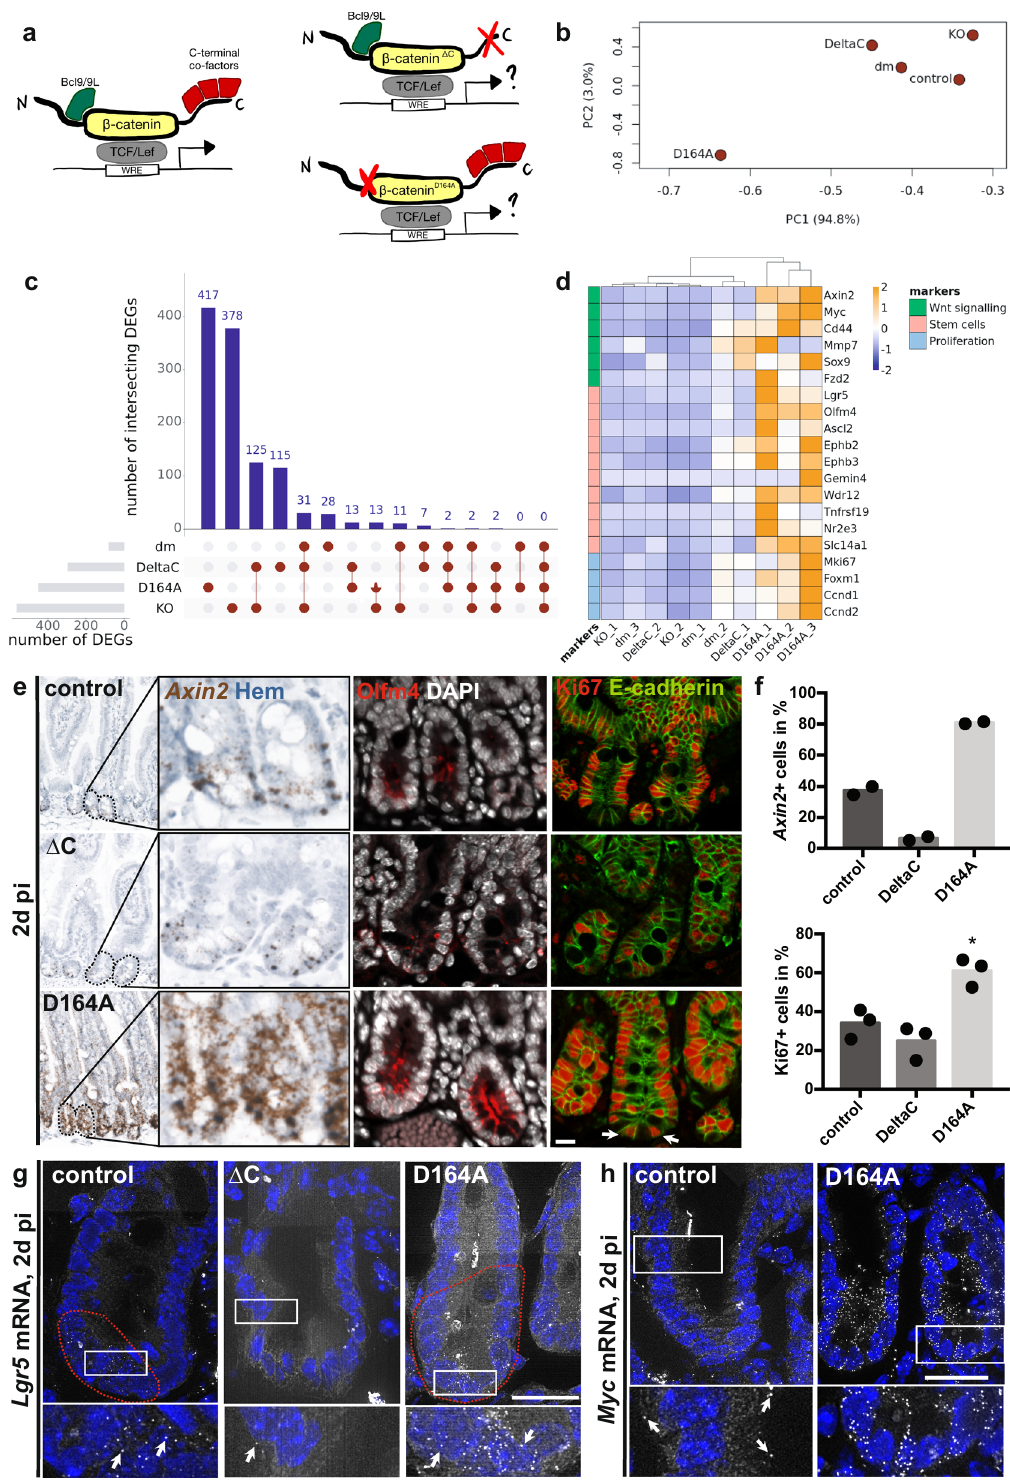
(Fig. 1g and Supplementary Fig. 2e). Furthermore, both the presence of Ki67 + cells at the bottom of D164A crypts (white arrows in Fig. 1e, and evidenced in Supplementary Fig. 2f) and upregulated Myc expression at crypt base (Fig. 1h) indicate increased IESC proliferation. These results indicate that prevent- ing β -catenin ’ s interactions to CTFs completely represses the Wnt-outputs, including proliferation and IESC-associated genes, hence compromising stem cell maintenance. On the contrary,